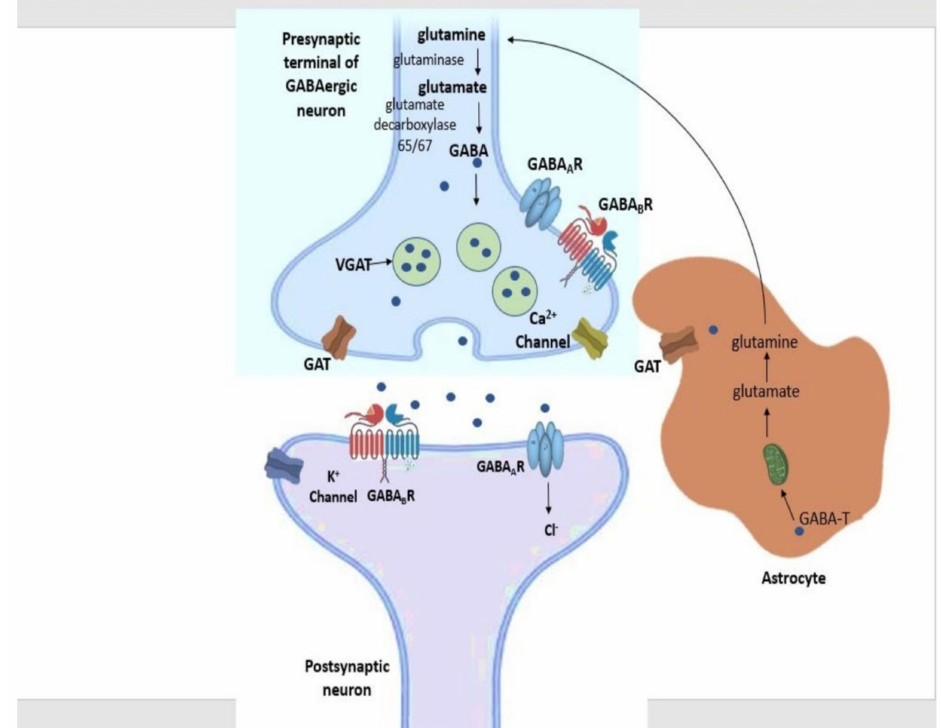
Figure 2. GABAergic Signaling. Glutamine is first converted to glutamate via action of the enzyme glutaminase. GABA is synthesized from the breakdown of glutamate by glutamic acid decarboxylase (GAD). GABA is then transported to the synaptic vesicle of the pre-synaptic terminal through the vesicular GABA transporter (vGAT) and is released into the synapse, where it binds to either of the GABA receptors GABA A or GABA B on the postsynaptic neuron, thus inhibiting it. Upon inhibition, excess GABA is moved from the synapse and into astrocytes via GABA transporters (GATs), where it is ultimately converted back to glutamate and then glutamine through the initiatory action of GABA transaminase (GABA-T) within the